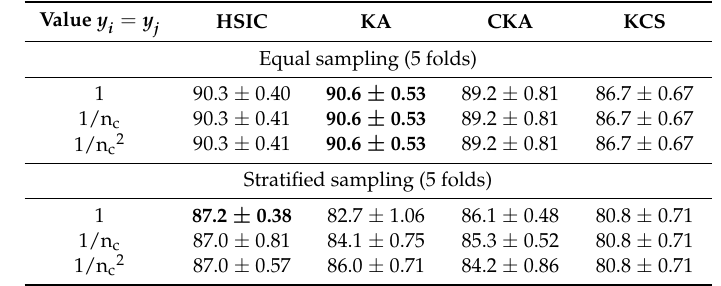
Table 4. The overall accuracy obtained for Experiment I.B.: optimizing both the bandwidth parameters γ m for each input kernel K m and the relative kernel weights η using various kernel class separability measures and ideal kernel definitions. n c indicates the number of samples for a specified